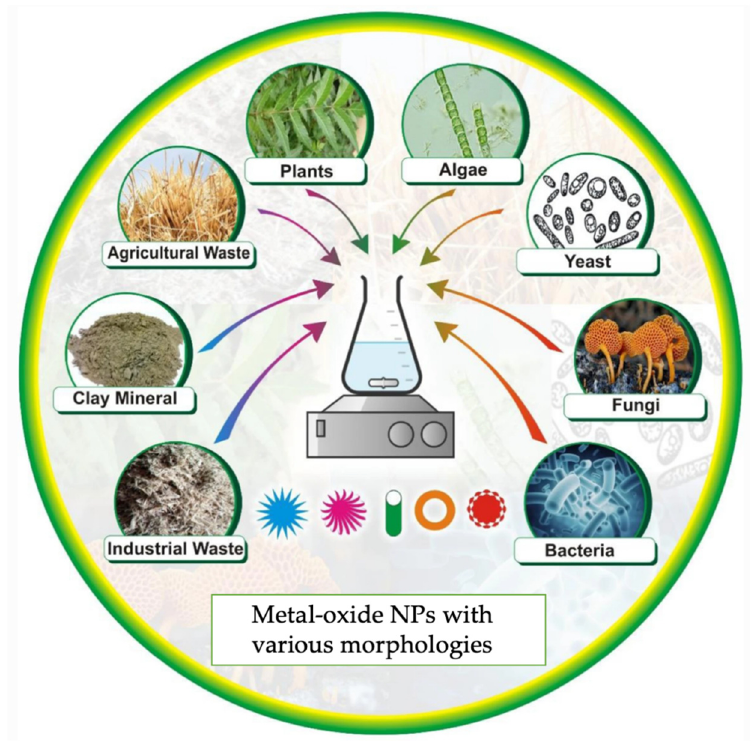
Figure 4. Biological resources for the green synthesis of metal-oxide NPs [65].